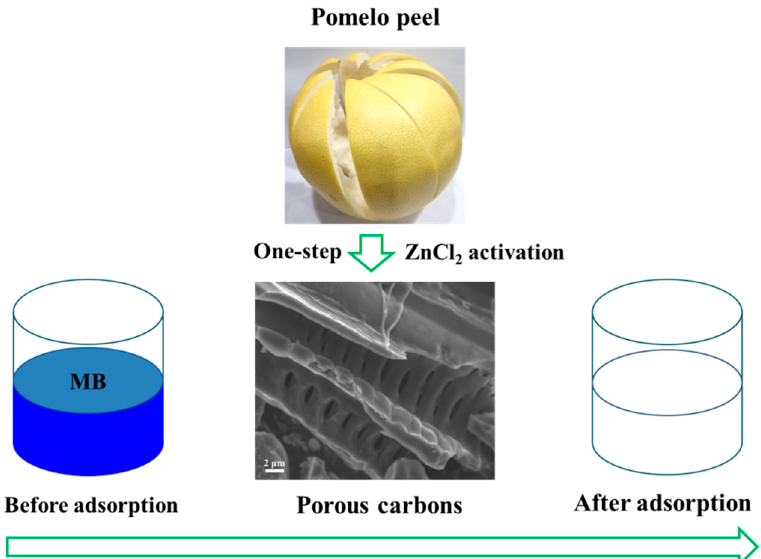
Figure 1. Illustration of the synthesis and adsorption application of PPPC.